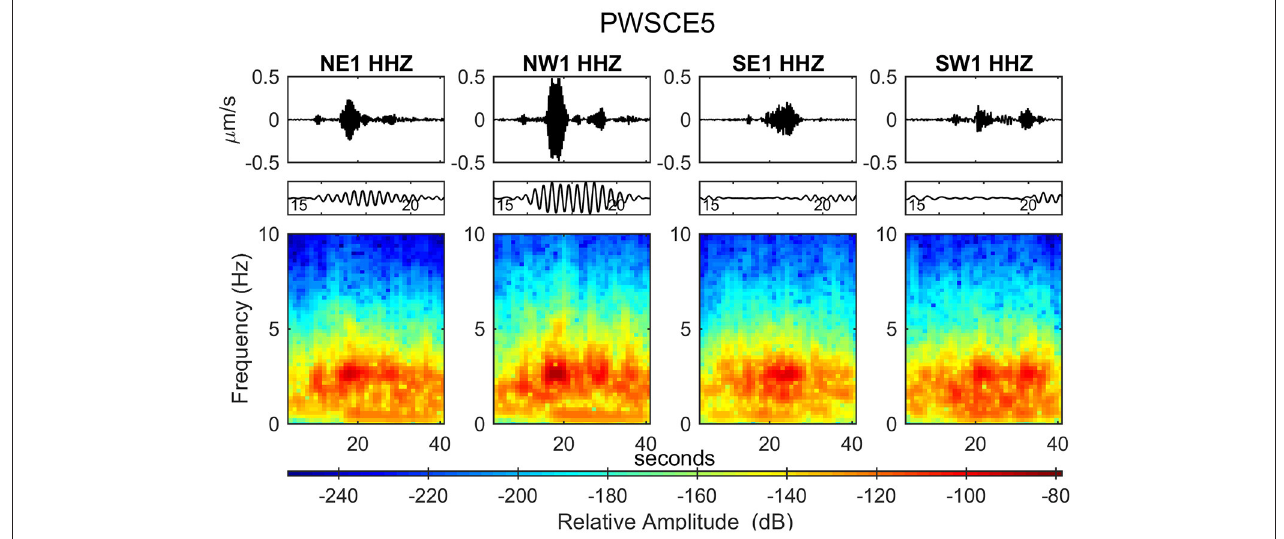
FIGURE 11 | Top Row—PWSCE5 traces. Middle Row—Zoom-in of stacked signal onset. Bottom row—Spectrogram (512 sample window with 80% overlap) of